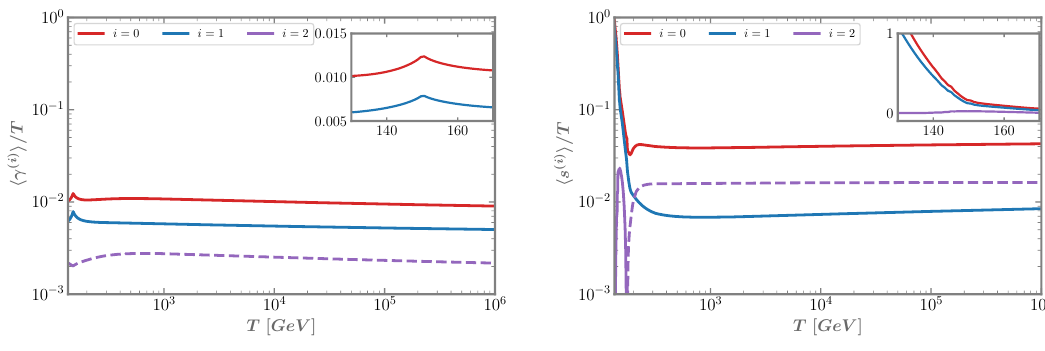
Figure 2 . Temperature dependence of the ratios h γ ( n ) negative contribution of a partial